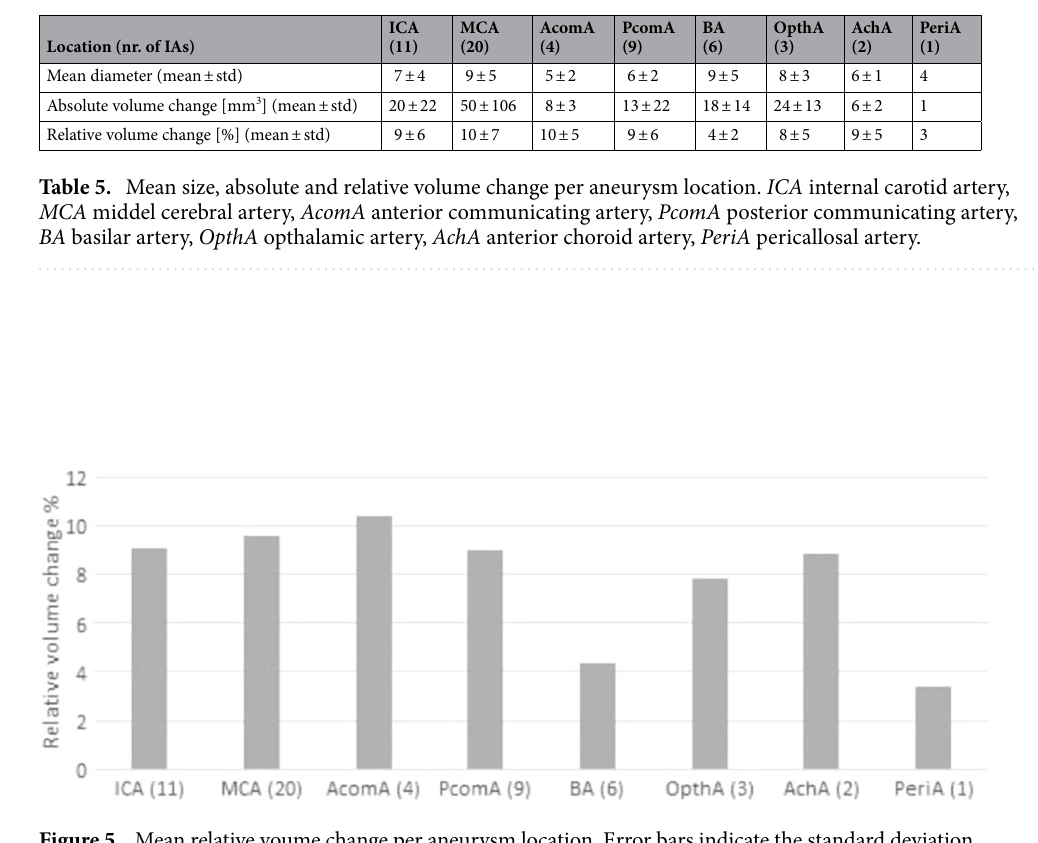
Location (nr. of IAs)